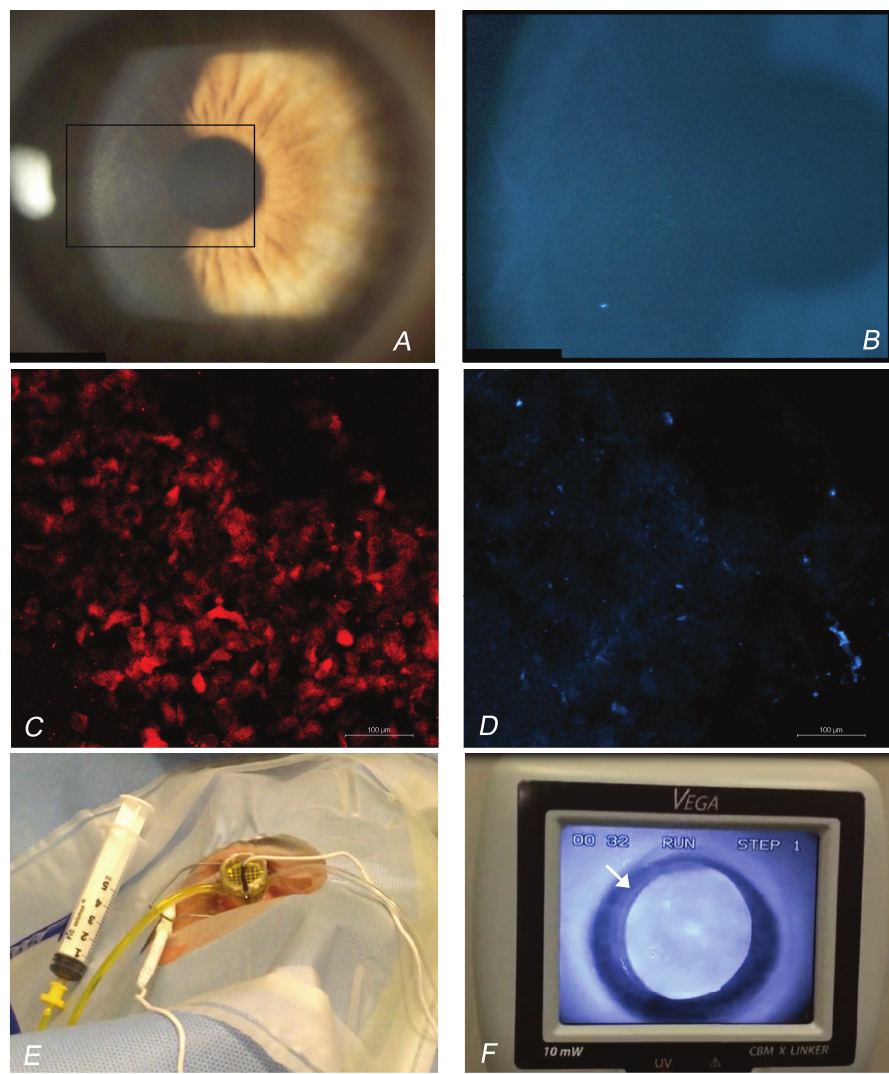
Figure 1: (A) Slit-lamp photograph of the cornea 1 minute after the applanation with the Biopore membrane. (B) The corneal epithelium showed moderate punctate staining with fluorescein dye (molecular weight: 376 Da). (C) Homogeneous immunofluorescent staining for MUC4 mucin (false color red) was found on Biopore membranes where the cornea was applanated. (D) A small number of scattered epithelial cells (false color blue) were observed on the membranes. In (C) and (D), scale bars are 100 𝜇 m. (E) Iontophoresis was performed with the current intensity set at 1.0mA for 5 minutes using a commercial device. (F) After iontophoresis, the cornea was irradiated using 10 mW/cm 2 UV-A device for 9 minutes. The arrow indicates the mark of the suction tube on the corneal epithelium. Strong fluorescence was emitted by stromal riboflavin inside the area of iontophoresis